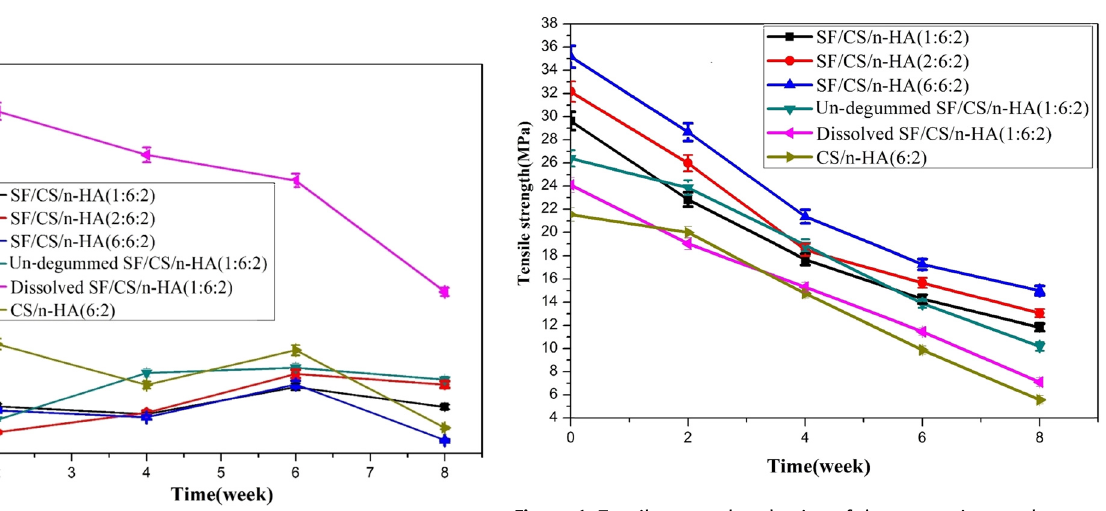
Figure 4: Weight loss of the composite membranes during the soaking.